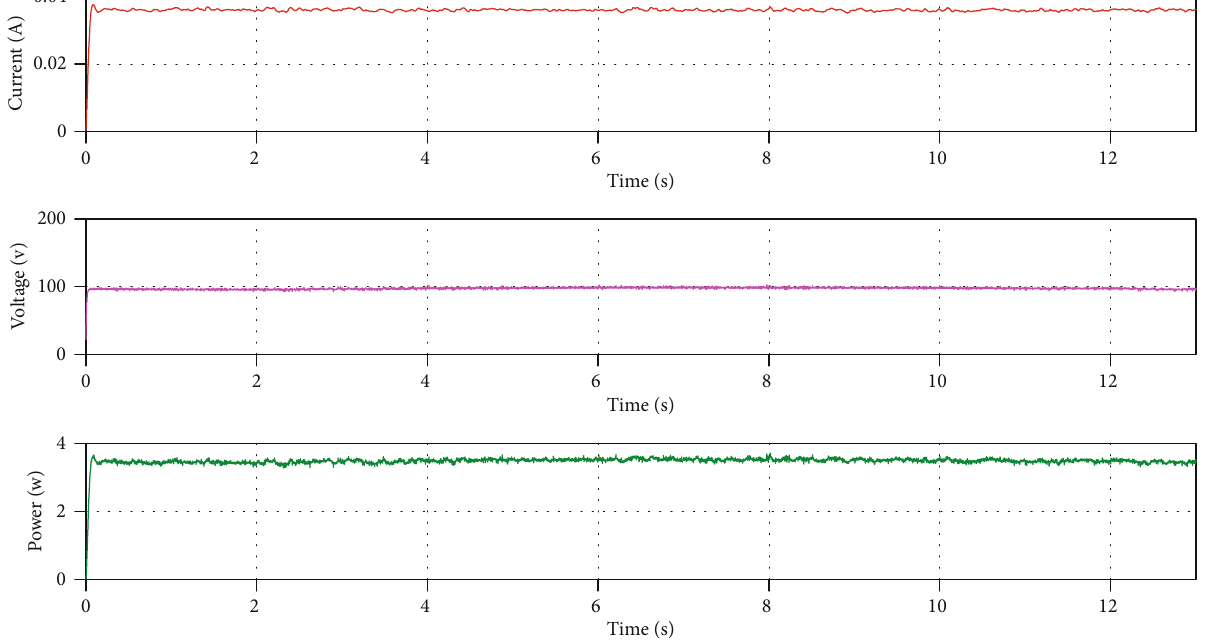
Figure 19: Experimental results of the proposed MPPT controller during uniform irradiance.